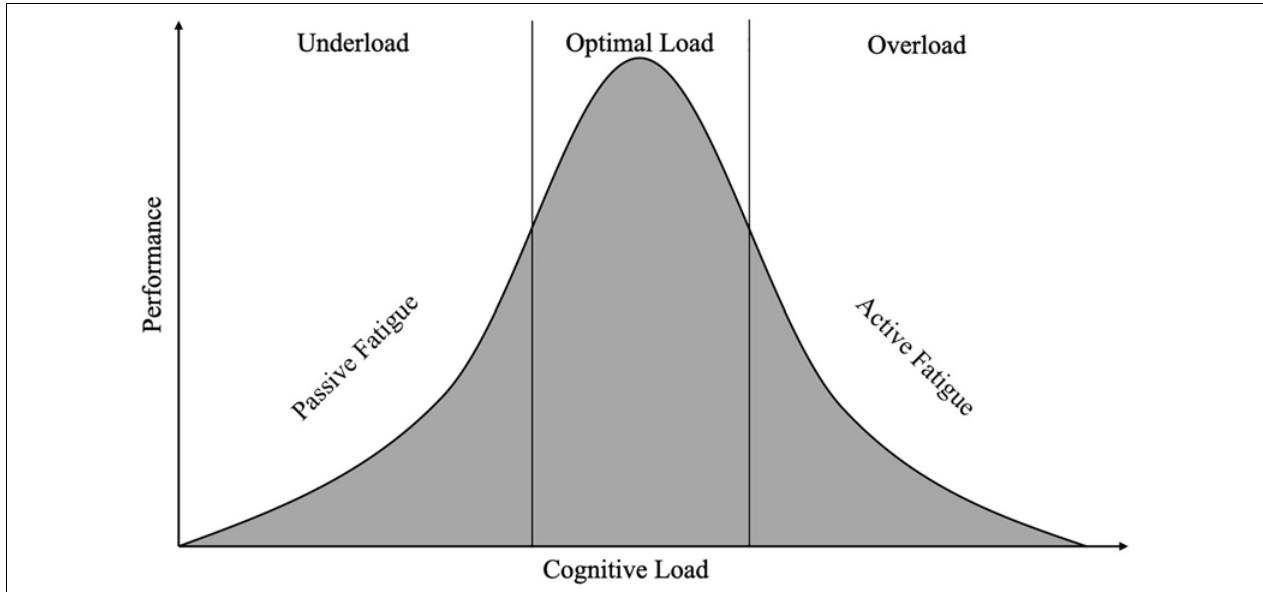
FIGURE 1 | Curve demonstrating the relationship between cognitive load and task performance. The left section shows when someone is underloaded and experiencing passive fatigue which is associated with poor task performance. The center section shows how a certain amount of cognitive load is associated with better performance. The right section shows overload which leads to active fatigue and is associated with poor task